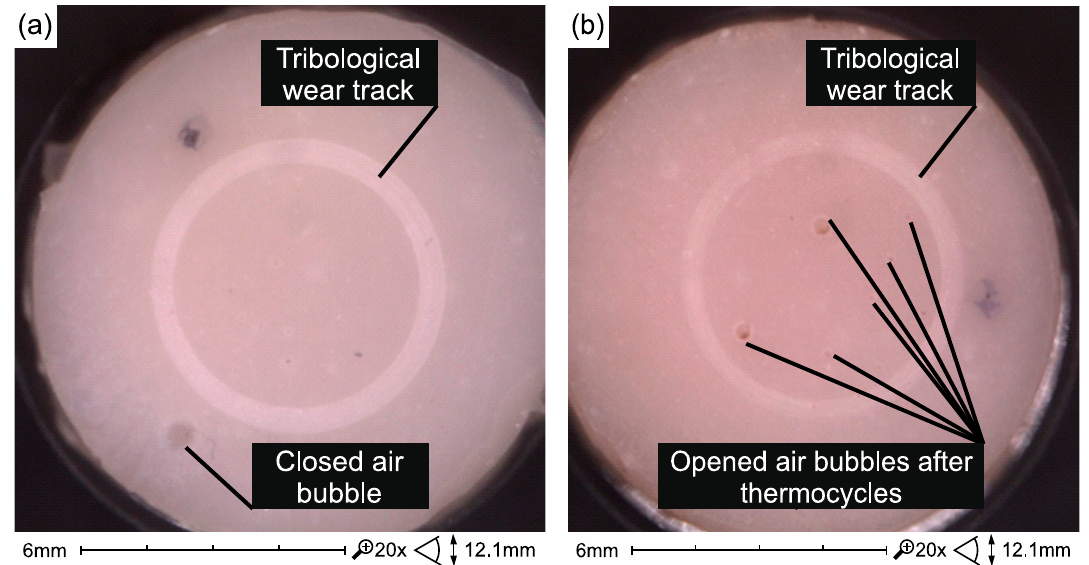
Figure 12. Surface of Ex-flow(P) composite samples without ( a ) and after thermocycling ( b ) and testing on a tribometer.